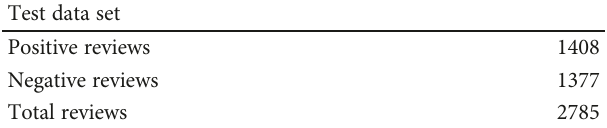
Figure 6: General diagram of the CNNs used. Table 1: Model structure.